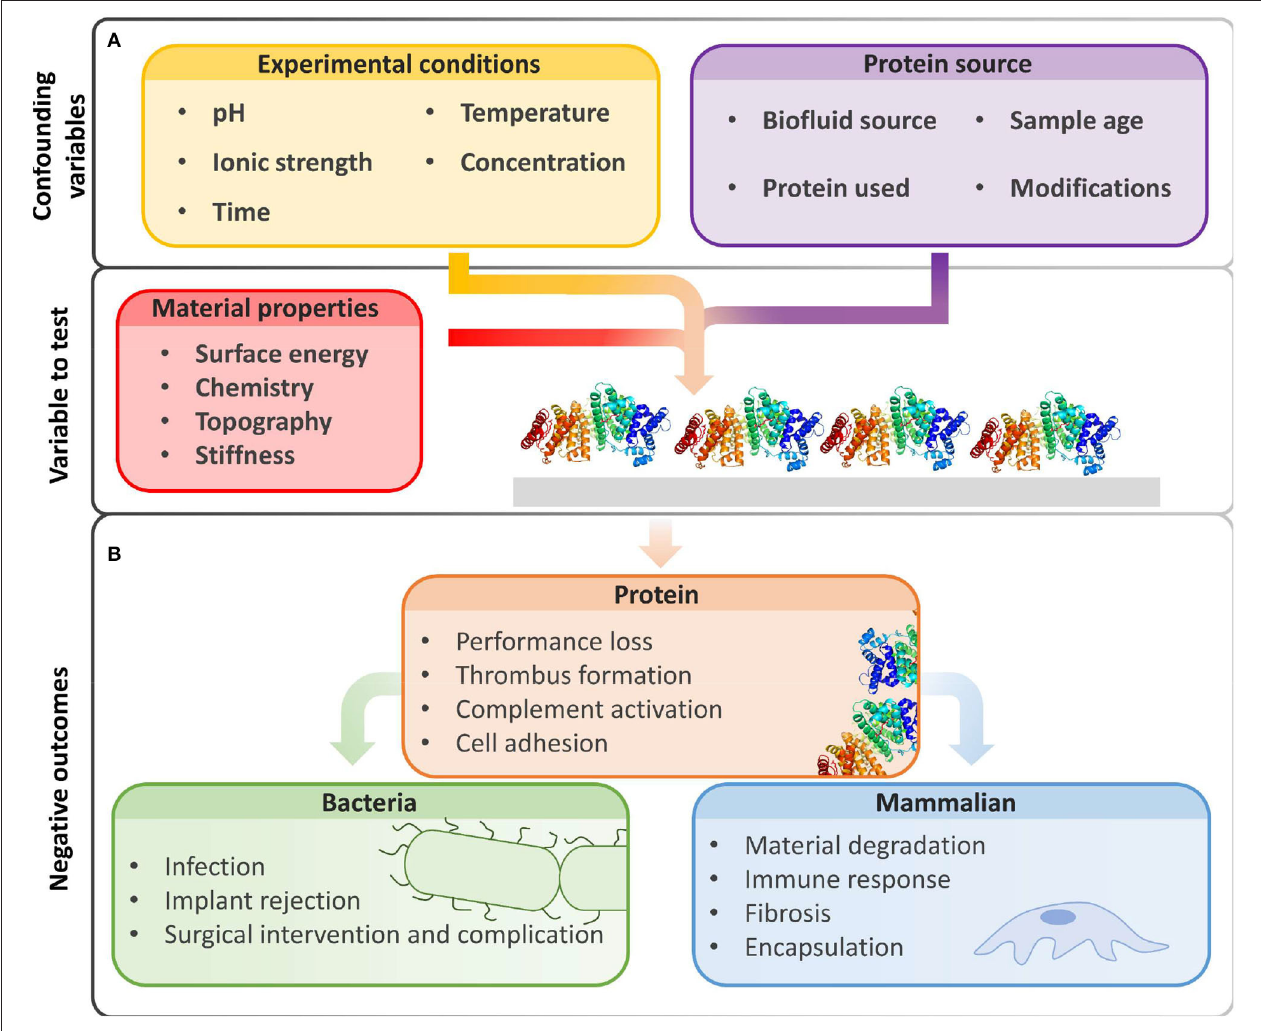
FIGURE 1 | Beyond intrinsic material properties, experimental conditions and biological reagents greatly influence fouling results. (A) The amount of non-specific protein adsorption on biomaterial surfaces is influenced by experimental conditions and protein sources chosen by the user. (B) Biofouling may hinder device performance and produce unwanted biological events due to non-specific protein adsorption, increased bacterial adhesion, and deleterious interactions with mammalian cells. Image of PDB ID 1BJ5 (Curry et al., 1998) created with (PyMol,